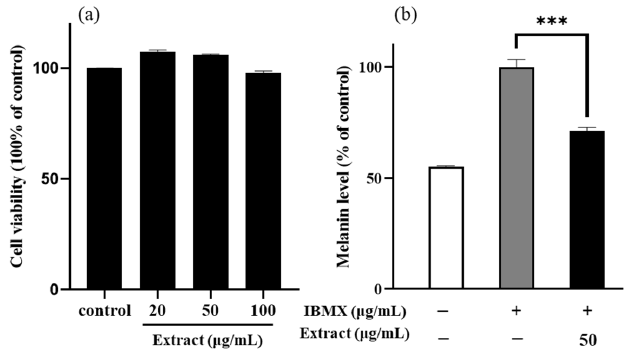
Figure 1. Cell viability ( a ) and melanin content ( b ) in B16/F10 cells treated with enriched PLS extract. * p -value < 0.05 and *** p -value < 0.001 were compared with control group and IBMX induced group, respectively.